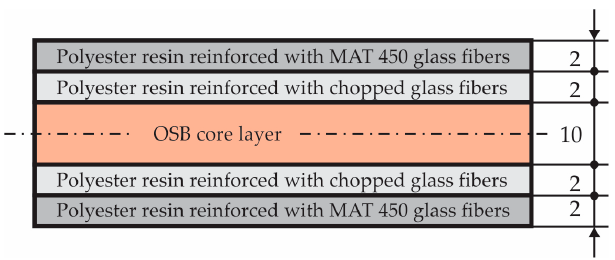
Figure 1. Structure of the sandwich composite material used to manufacture the manhole